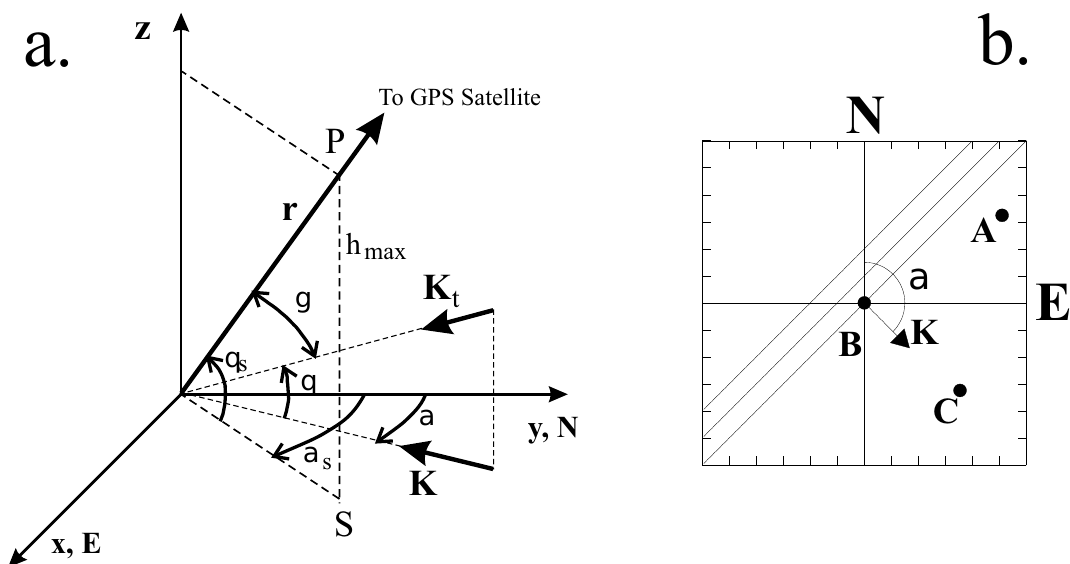
Fig. 7. (a) – schematic representation of the transionospheric sounding geometry. The axes z , y , and x are directed, respectively, zenithward, northward (N) and eastward (E). P – point of intersection of LOS to the satellite with the maximum of the ionospheric F2-region; S – subionospheric point; α s – the azimuthal angle, counted off from the northward in a clockwise direction; and θ s – the angle of elevation between the direction r along LOS and the terrestrial surface at the reception site; γ – the angle between the vectors K t and r . (b) – GPS- array geometry; A, B, C – receiver points, at which two-frequency multichannel GPS-receivers are installed. Parallel lines correspond to lines of equal TEC. The arrow indicates the vector K in the direction α